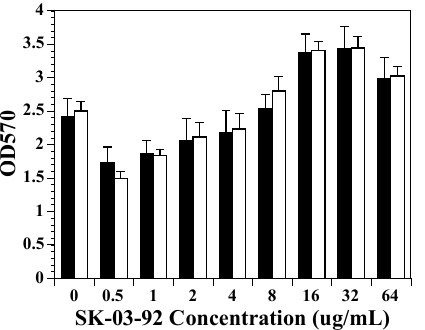
Figure 3. The effects of SK-03-92 drug concentration on 24 h biofilm formation (OD 570 ) for S. aureus strains JE2 (black column) and MW2 (white column). All experiments represent the mean + standard deviation of at least 10 runs done in triplicate.